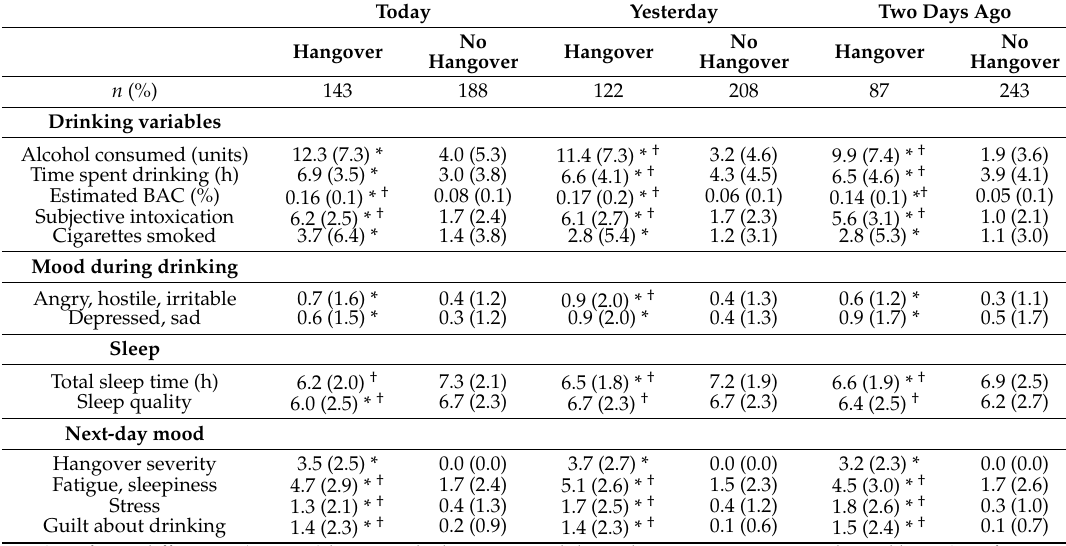
Table 2. Study outcomes and their association with hangover